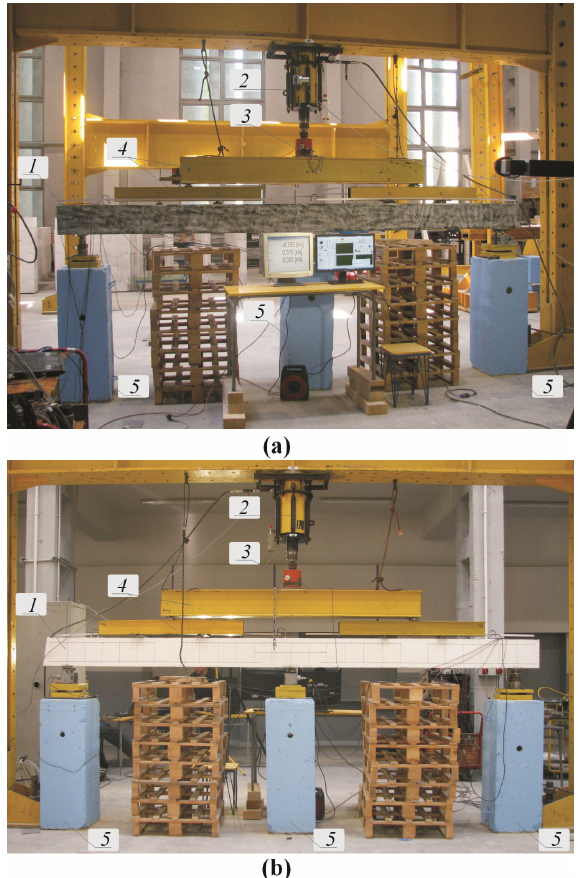
Figure11. Reinforcedconcreteelementsattheteststand: ( a )fromthesideofopticalmeasurements,( b )from the side of making observations of cracks; 1—test element, 2—hydraulic actuator, 3—electro-resistant dynamometer, 4—steel beams for load distribution; 5—supports of the test